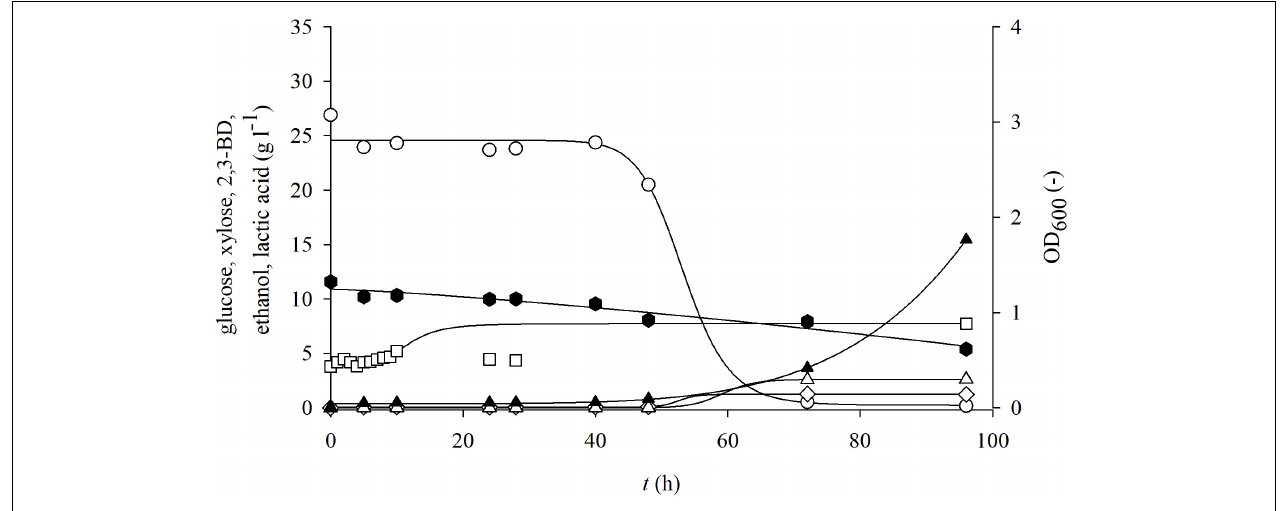
FIGURE 5 | Changes in optical density (OD 600 , (cid:3) ) and concentration of glucose ( (cid:13) ), xylose ( ), 2,3-BD ( (cid:5) ), ethanol ( (cid:52) ), and lactate ( (cid:78) ) during cultivation of bacterium P. polymyxa DSM 742 in media with liquid phase of dilute acid BSG hydrolysate in the stirred tank bioreactor.